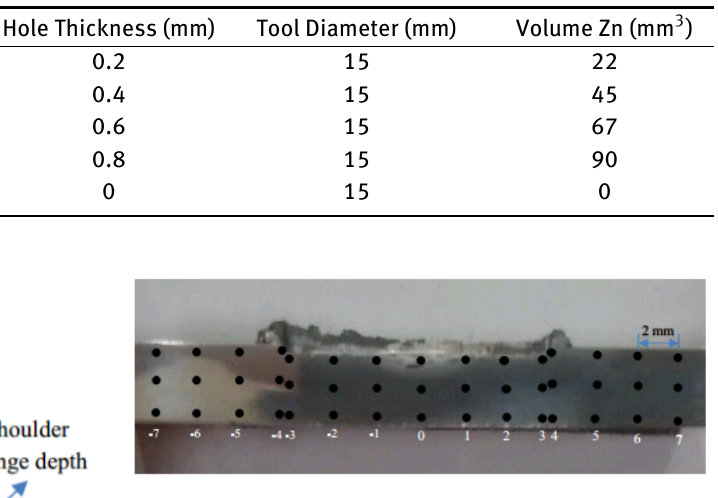
Figure 2: Mapping the measurement point of the Vickers hardness